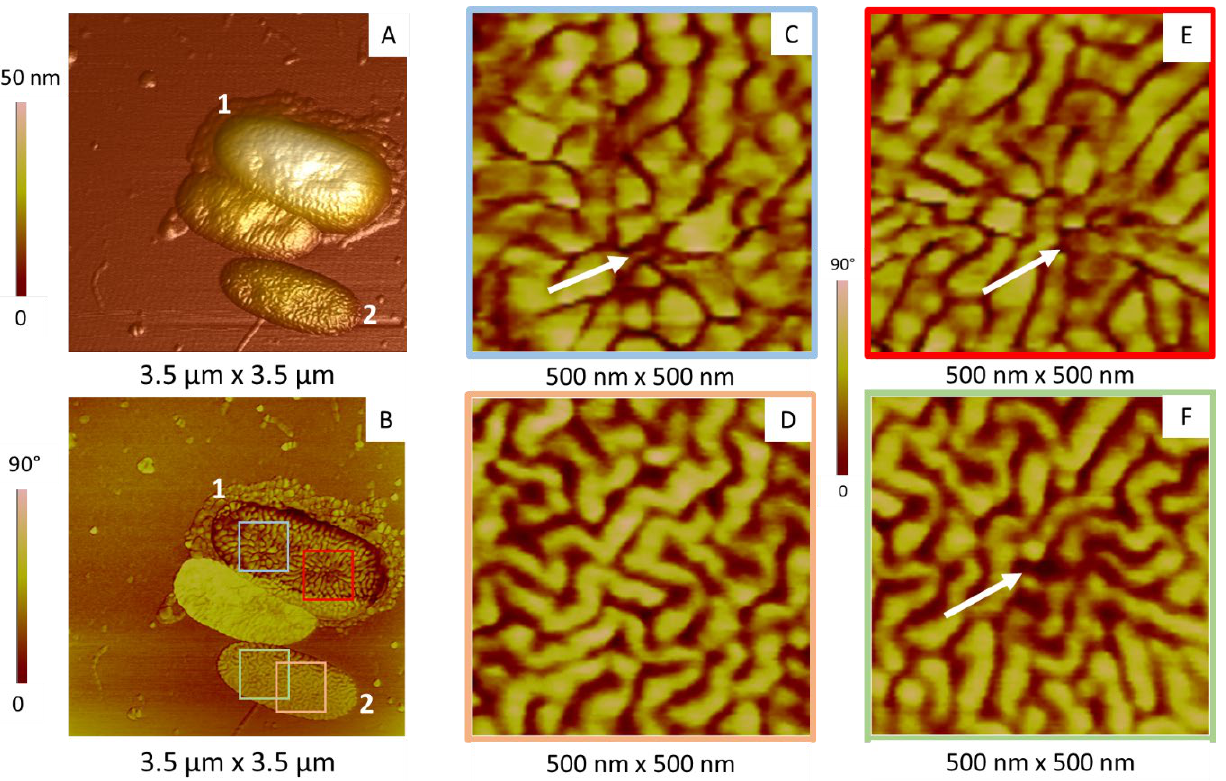
Figure 6. Relationship between membrane organization and invagination, shown by AFM images obtained in air and in tapping mode. ( A ) The 3D topographic images of three bacteria. Characteristics of cells numbered 1 and 2 are described in the main text; ( B ) corresponding phase image; ( C – F ) phase images of areas in the red, grey, green and yellow squares in figure ( B ), respectively. White arrows indicate the bottom of the invagination.